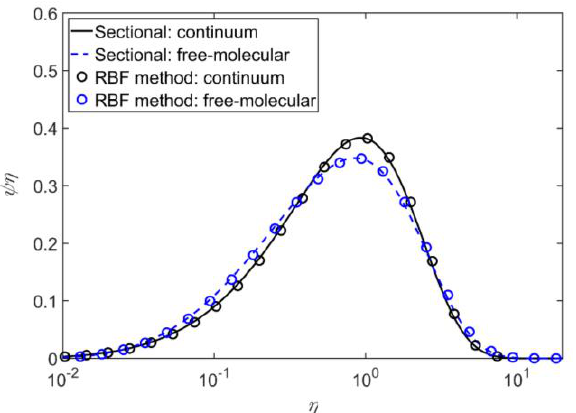
Figure 5. Self-preserving distributions predicted using the RBF and the sectional methods for Brownian coagulation under the continuum and free-molecular regimes.